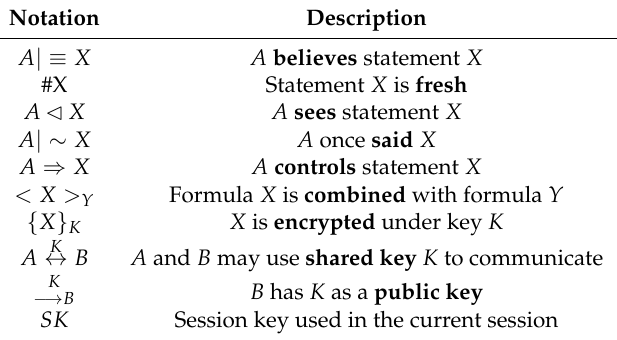
Table 2. Notations for BAN